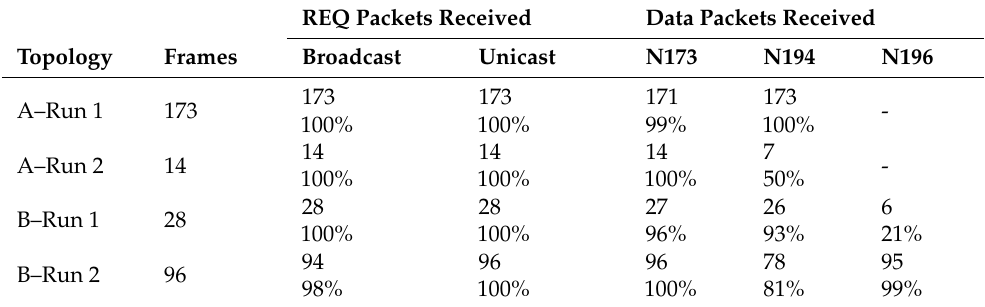
Table 5. Packet statistics at the relay node